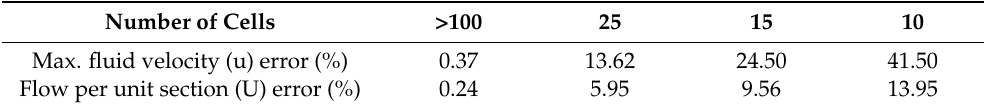
Table 1. Fluid velocity and flow per unit section relative errors as a function of the number of cells. Parallel plate channel. Single material. Charged medium with uncharged walls.